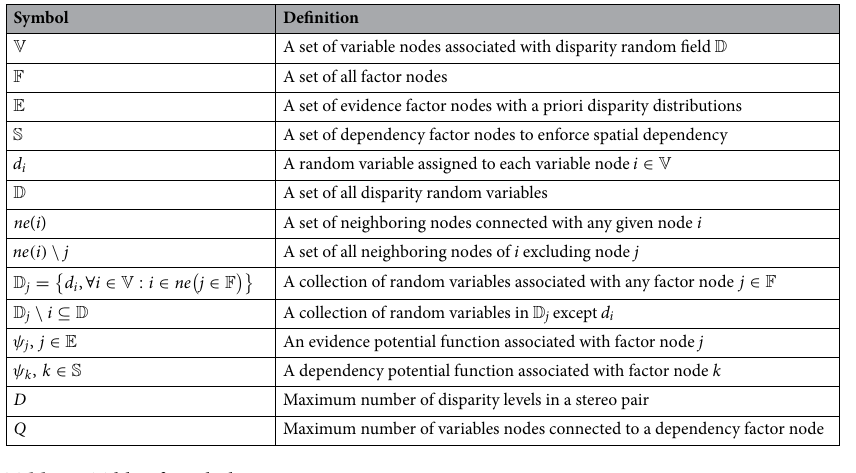
Table 1. Table of symbols.